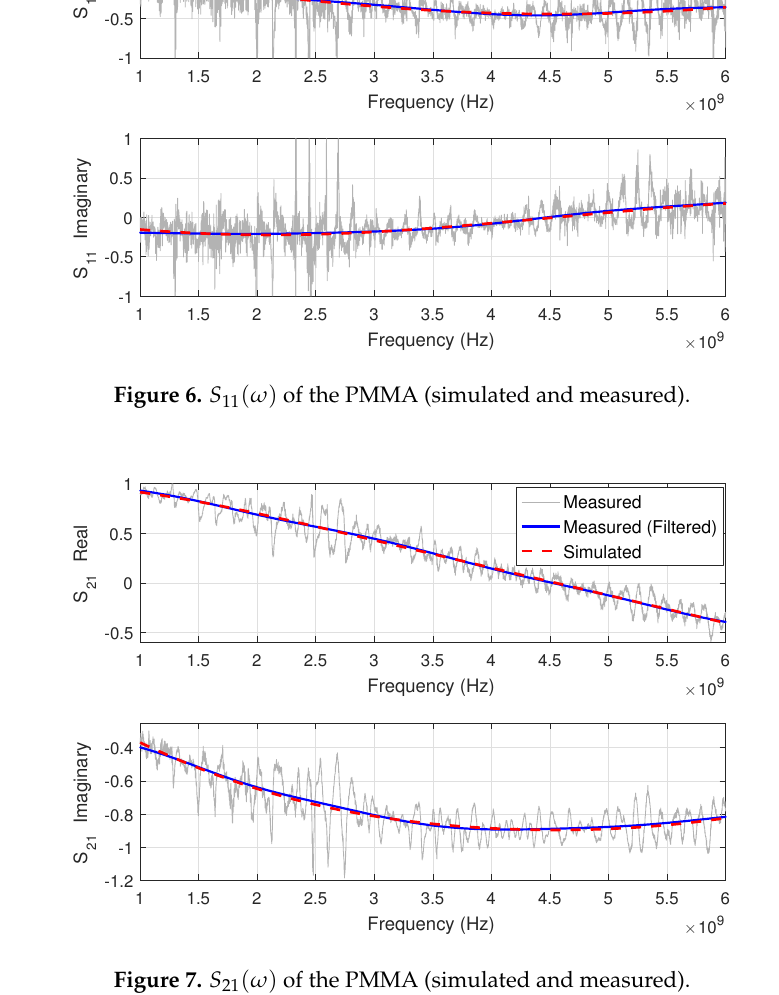
Figure 7. S 21 ( ω ) of the PMMA (simulated and